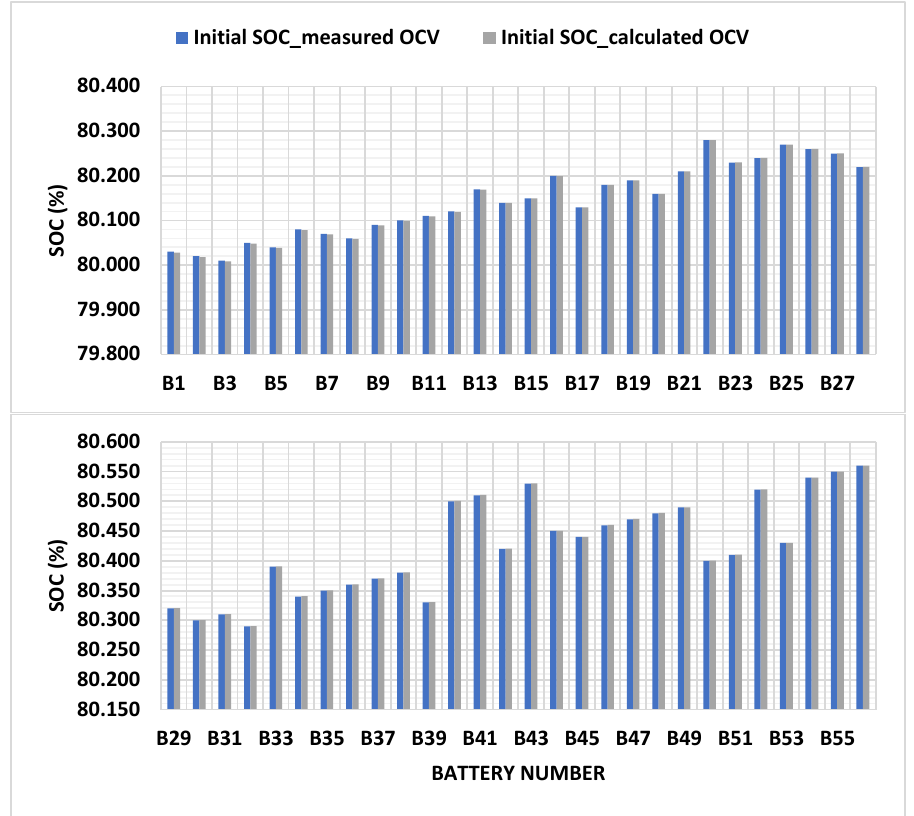
Figure 15. Battery SOC in the SM-EBs in the upper arm of phase A.